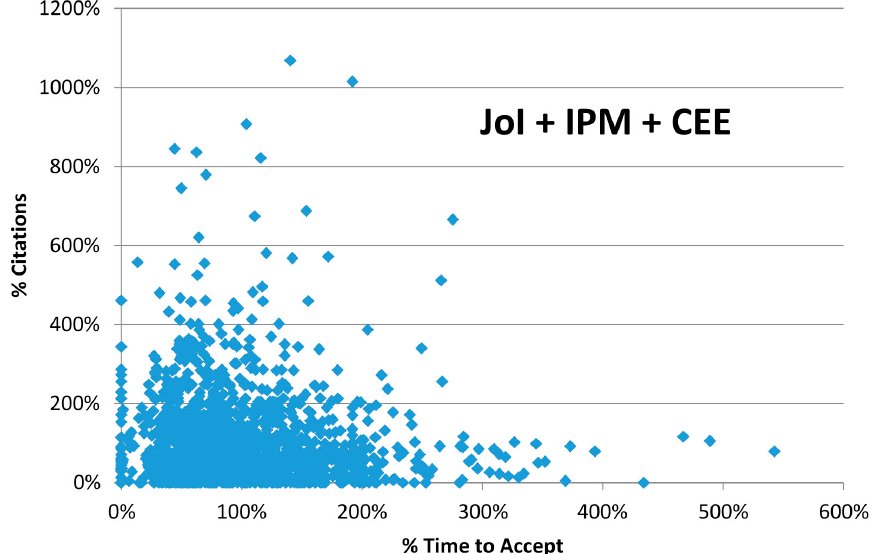
Figure 5. Scatter plot of times to accept (as percentage ratio of days to accept to mean days to accept in a specific year) versus citations (as percentage ratio of citations to citations per paper in a specific year) of combined papers from Journal of Informetrics , Information Processing and Management , and Computers and Electrical Engineering ( n = 1541, r = ´